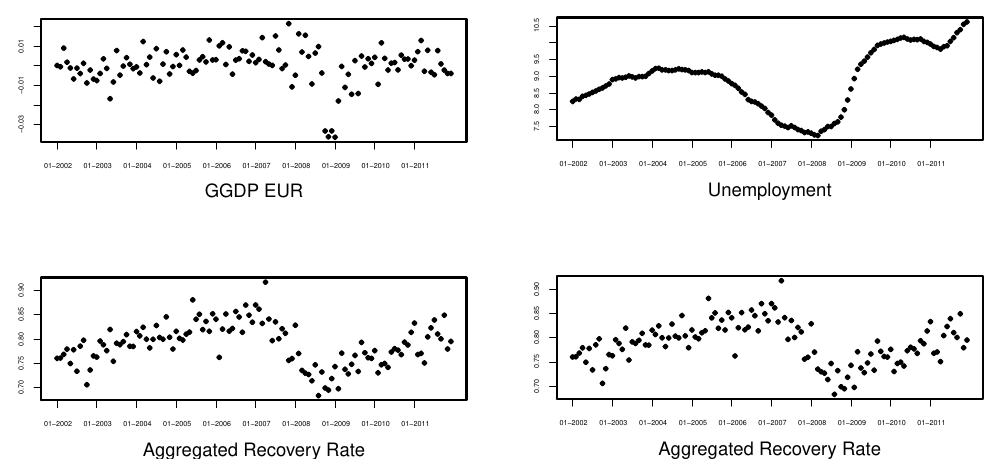
Figure 6. European GGDP ( top left ) and Unemployment ( top right ) vs. aggregated recovery rates ( bottom ).